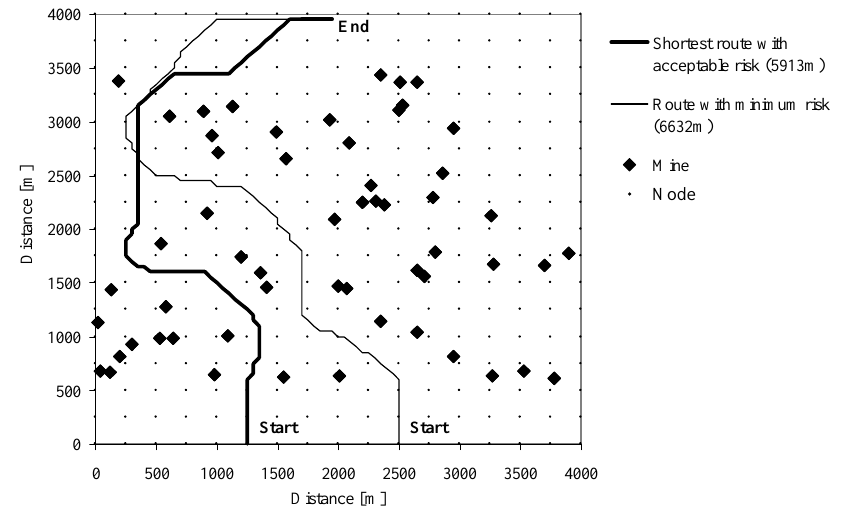
Figure 5: Examples of the routes of minimum risk from the open sea (bottom) into a harbour (top) through a random minefield with safety radius = 250m, grid spacing = 50m (for clarity only every fifth grid point is